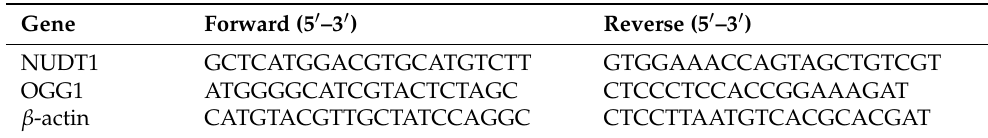
Table 1. The primer sequences for